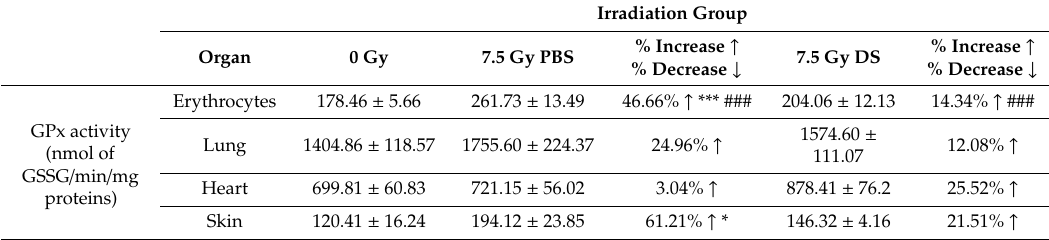
Table 2. GPx activity in erythrocytes, lung, heart and skin of mice irradiated by PBS or DS proton beams in the plateau phase of the Bragg peak.